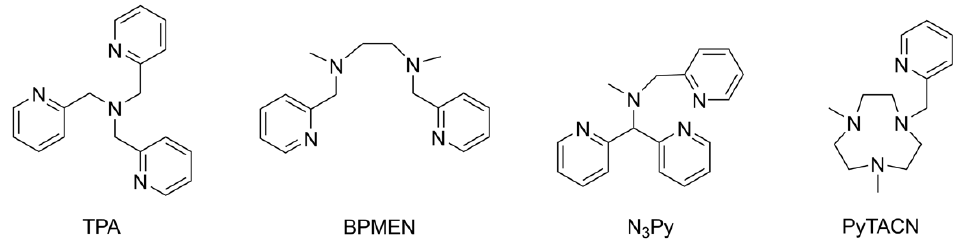
Figure 1. Select pyridine-based ligands that have been used to synthesize biomimetic metal com- plexes.